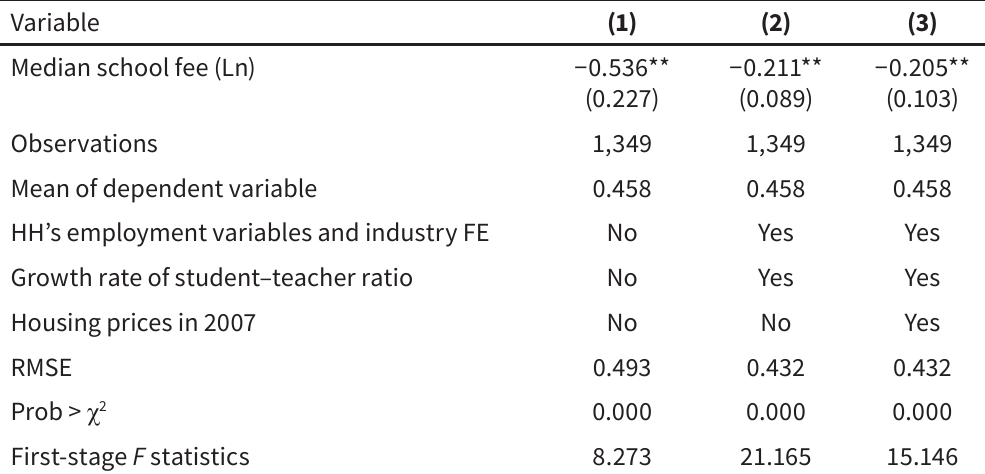
Effects of median school fees on the numbers of children brought to the city, China